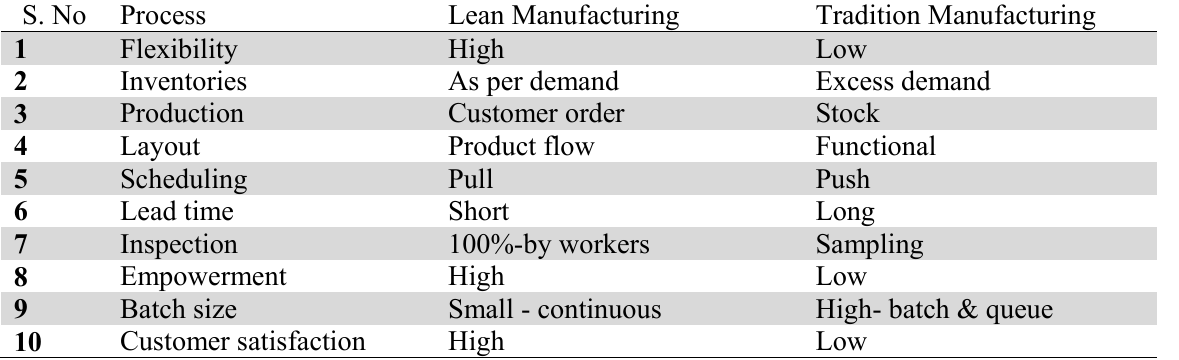
Major differences between lean and traditional manufacturing approaches S.